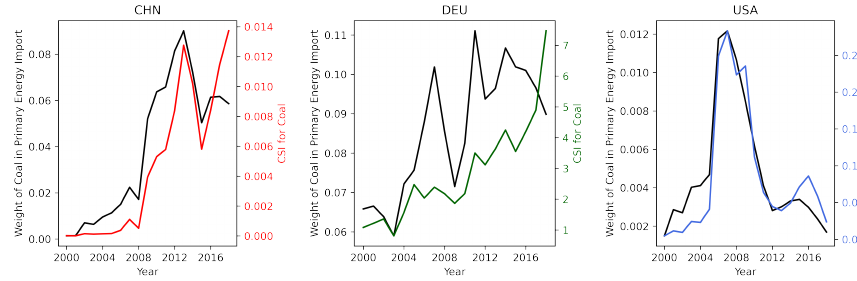
Figure 18. The evolution of CSI for coal